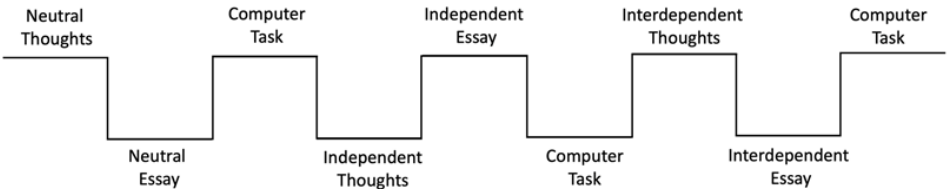
Figure 3. A schematic of the experiment procedure. The order of all three conditions was counterbalanced between subjects.